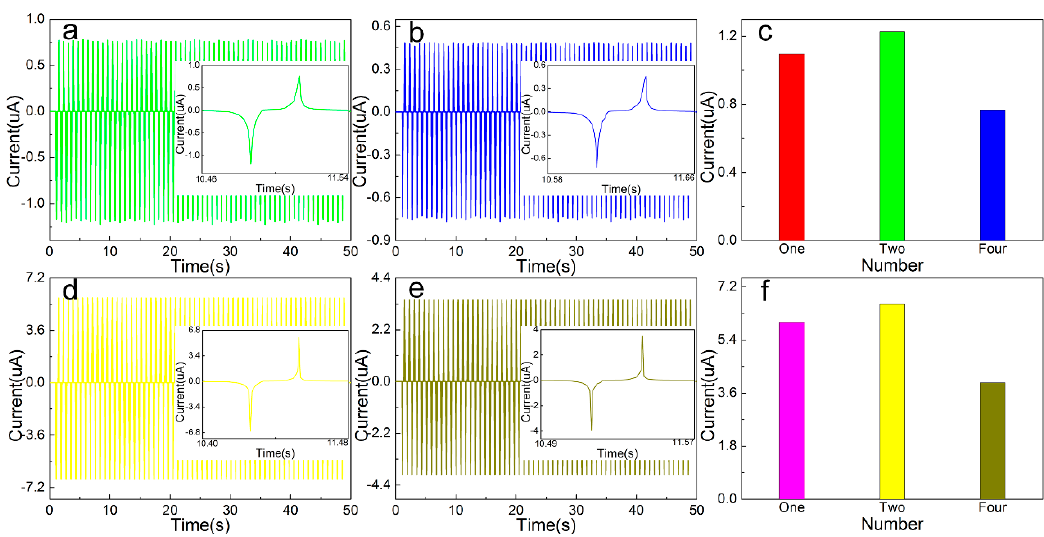
Figure 8. Output current of di ff erent number of TENG: ( a ) Cel, ( b ) Cel + PA6, ( c ) Cel + PA6 + BaTiO 3 , ( d ) Cel + PVDF, ( e ) Cel + PVDF + BaTiO 3 , ( f ) maximum instantaneous value.